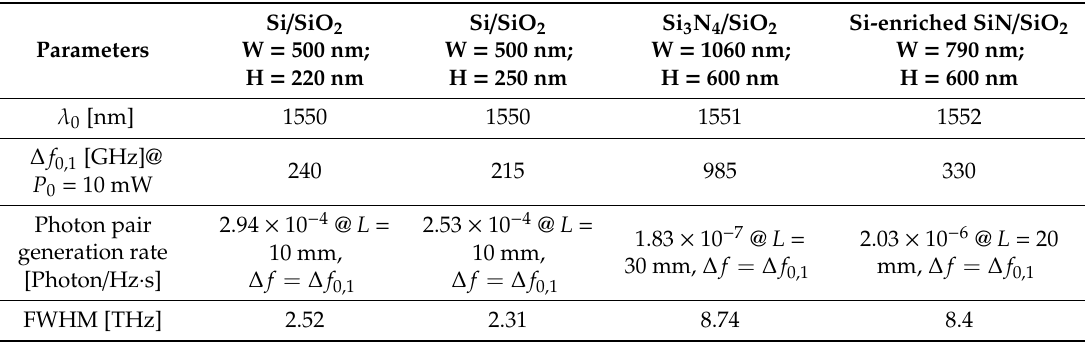
Table 1. Design Parameters for SOI and SiN